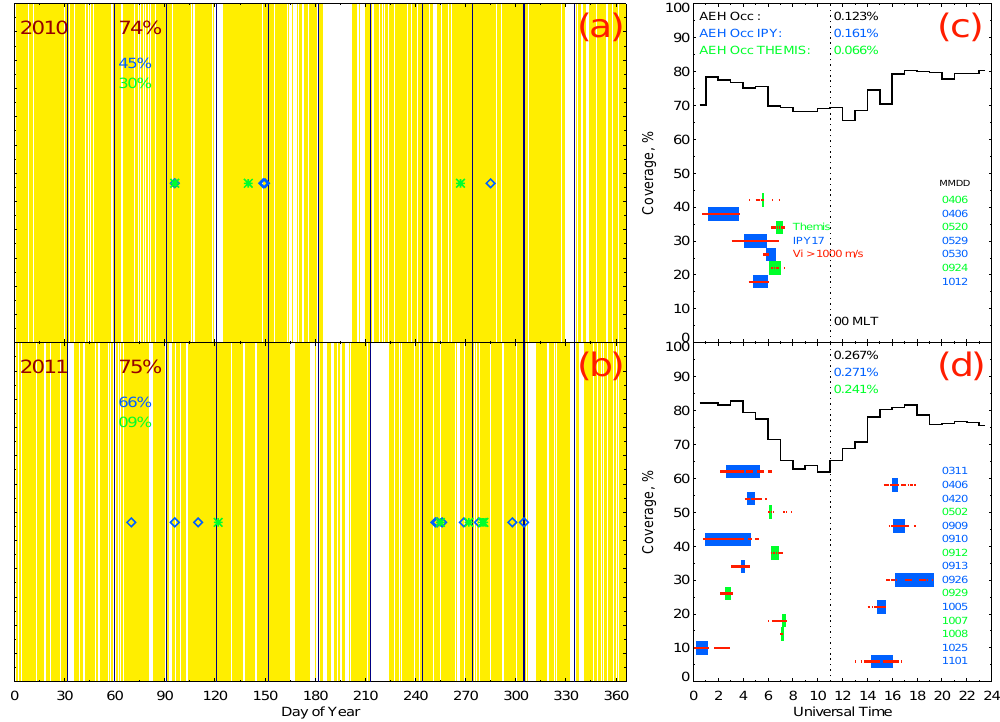
Fig. 4. PFISR coverage in 2010–2011 versus (a) and (b) time from start of the year and (c) and (d) universal time. The vertical dashed line in (c) and (d) shows magnetic midnight. The yellow areas in (a) and (b) show PFISR operating in the IPY or THEMIS mode. The diamonds (IPY) and asterisks (THEMIS) in the middle show identified AEH events. The percentages in (a) and (b) represent total coverage by both modes combined (top, red), by the IPY mode (blue, middle), and by the THEMIS mode (green, bottom). In panels (c) and (d) , the colour stripes show the AEH intervals in UT, while the red lines show intervals of elevated V E > 1000ms − 1 . The AEH events in the MMDD format are given at the right of panels (c) and (d) . The percentages in (c) and (d) show occurrence probability of AEH events for both modes combined and for each of the two